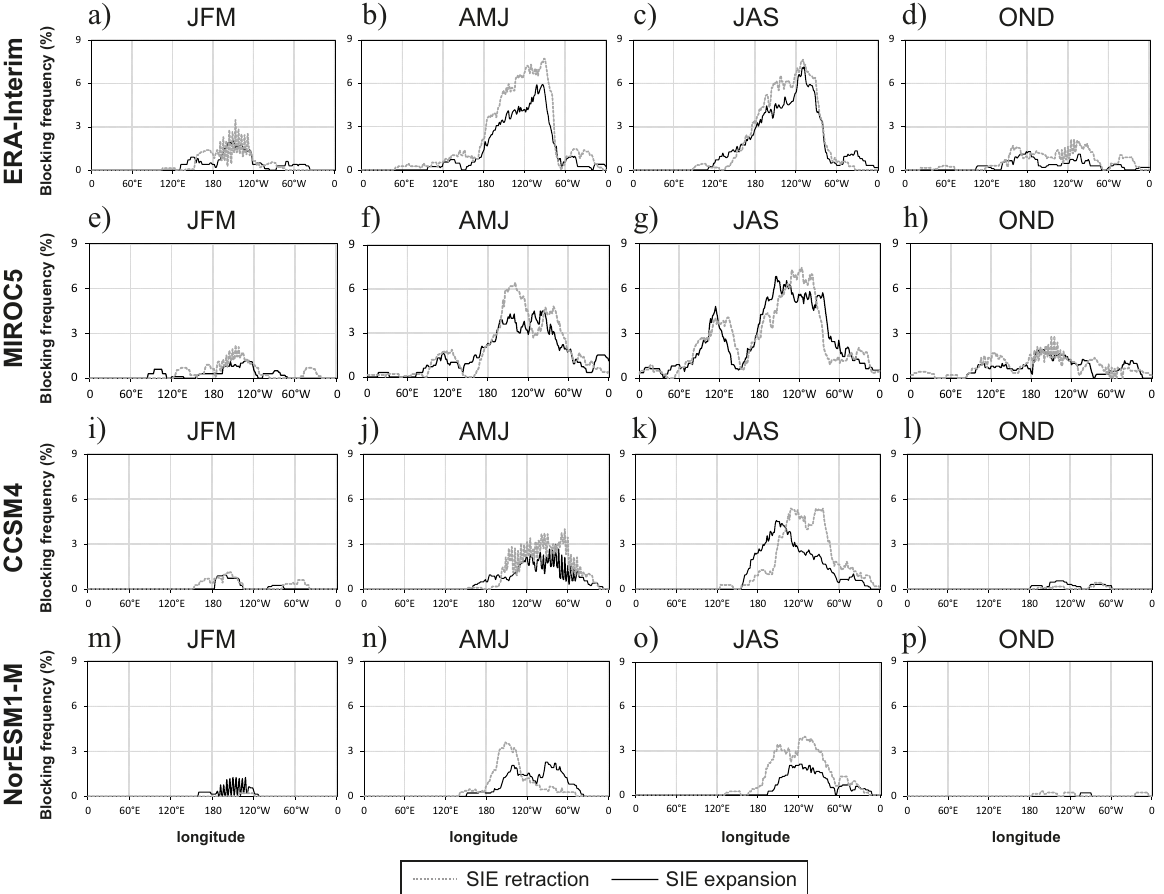
Figure 9. Seasonal frequency of blocking events, in the 60°S latitude band, in years of SIE Antarctic retraction (gray line) and expansion (black line) for (a, b, c, d) observed data (satellite and reanalyses), (e, f, g, h) MIROC5, (i, j, k, l) CCSM4 and (m, n, o, p) NorESM1-M during summer (JFM; first column), autumn (AMJ; second column), winter (JAS; third column) and spring (OND; fourth column) over